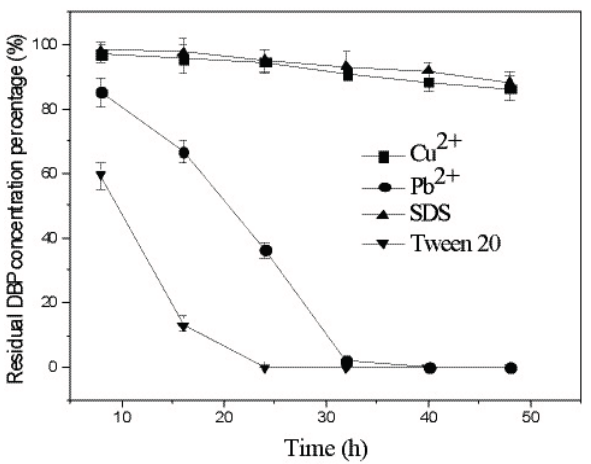
Figure 4. Effects of heavy metals and surfactants on the degradation of DBP. Error bars are the SEM of DBP concentration from triplicate